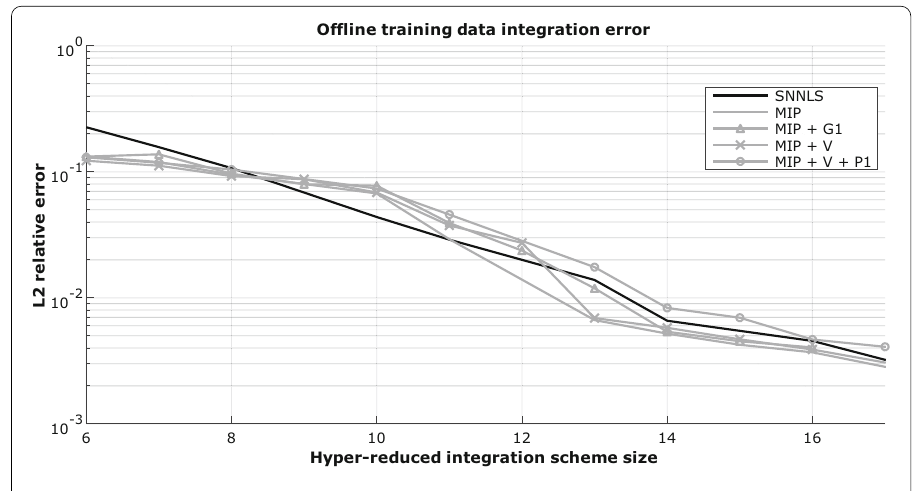
Fig. 4 Offline training data relative L2 error (33) for SNNLS and proposed hyper-reduced integration schemes selecting from 6 to 17 elements